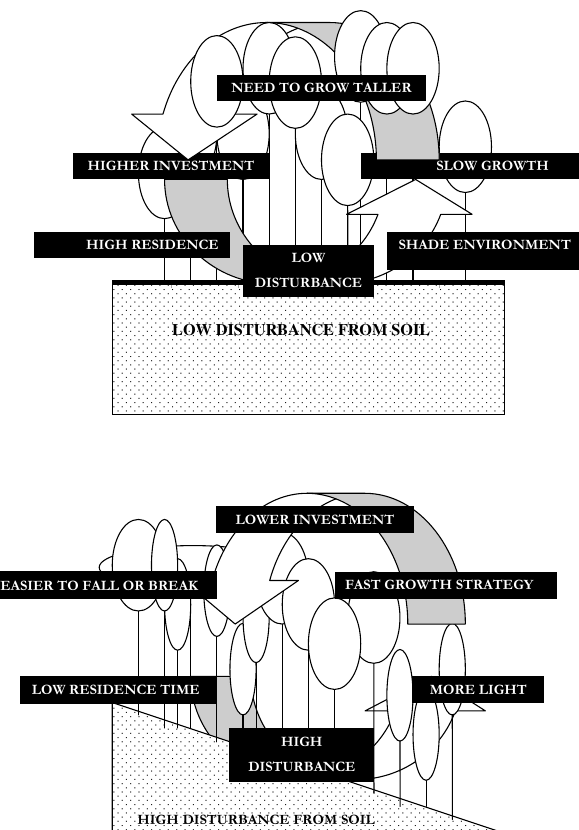
Fig. 17. Positive feedback mechanisms acting over floristic compo- sition and tree turnover rates. In the top the interacting mechanisms tend to select for conservative growth strategies and structural in- vestment, whilst in the bottom they tend to select for limited struc- tural investment but a rapid completion of the